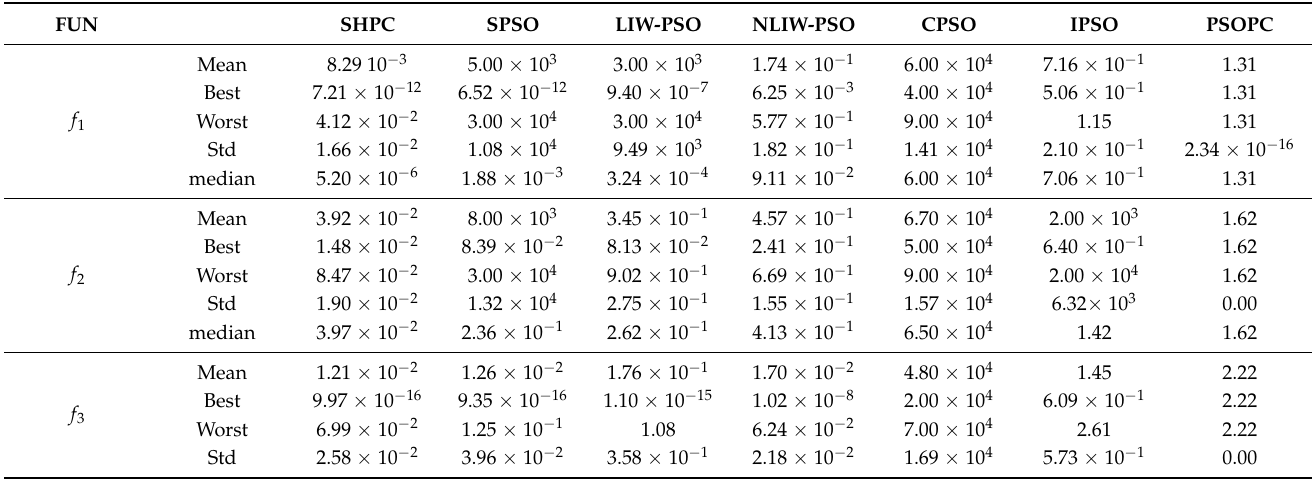
Table 3. Comparisons of experimental results between SHPC and PSO